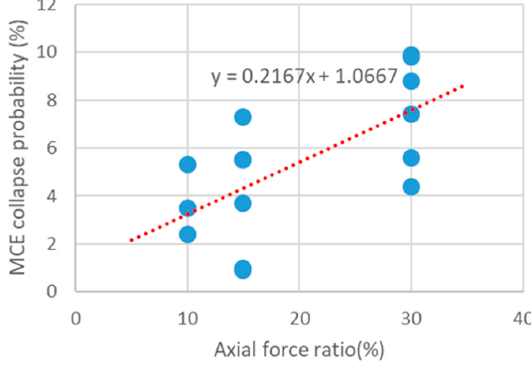
Figure 16. MCE collapse probability by axial force ratio.